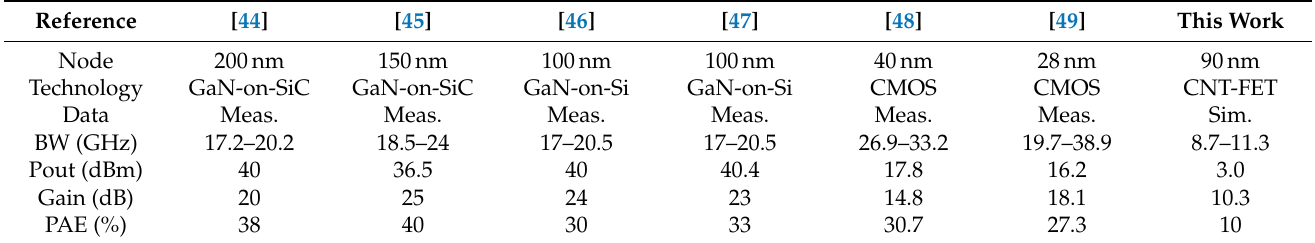
Table 1. Performance comparison of the designed HPA with other